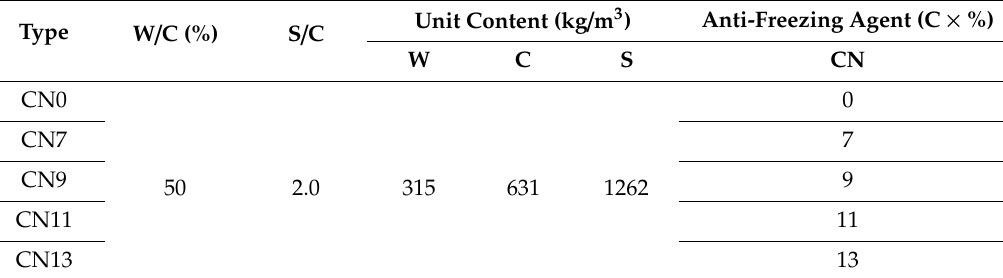
Table 3. Proportions of the mortar mix.